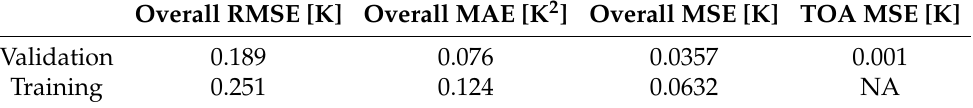
Table 1. TASI2DART performance assessment in terms of MAE, MSE, and RMSE for training and validation